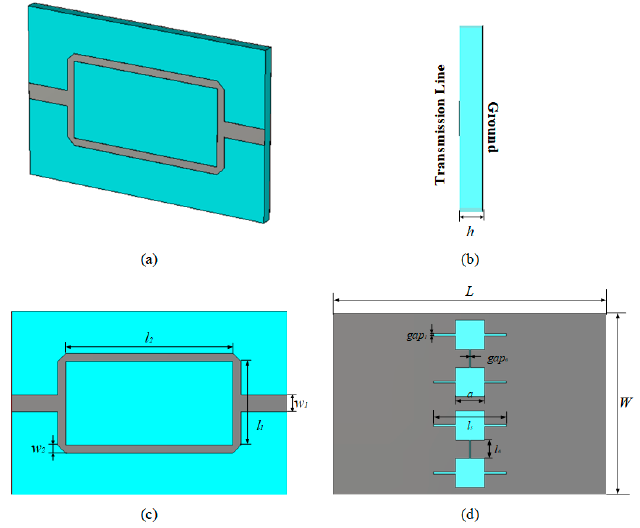
Figure 2. The structure of the basic sensor: ( a ) 3D structure of the basic sensor, ( b ) side view of the basic sensor, ( c ) top surface of the basic sensor, ( d ) bottom surface of the basic sensor. Table 1. The geometrical parameters of the basic design. Parameters Values (mm) Parameters Values